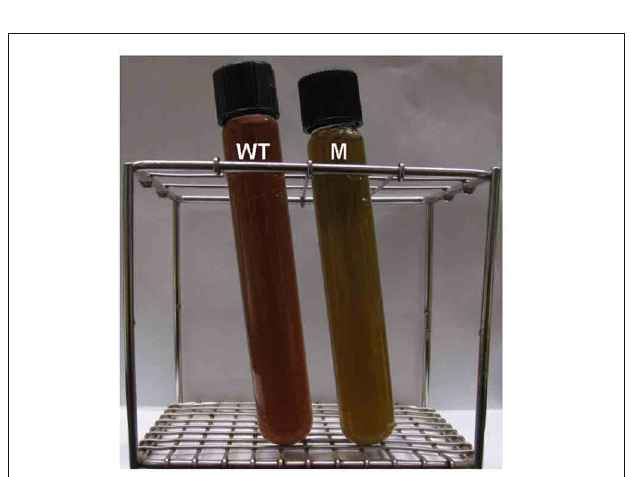
FIGURE 3 | Cultures of C. limnaeum 1677 T WT (tube WT) and the bchU mutant (tube M).